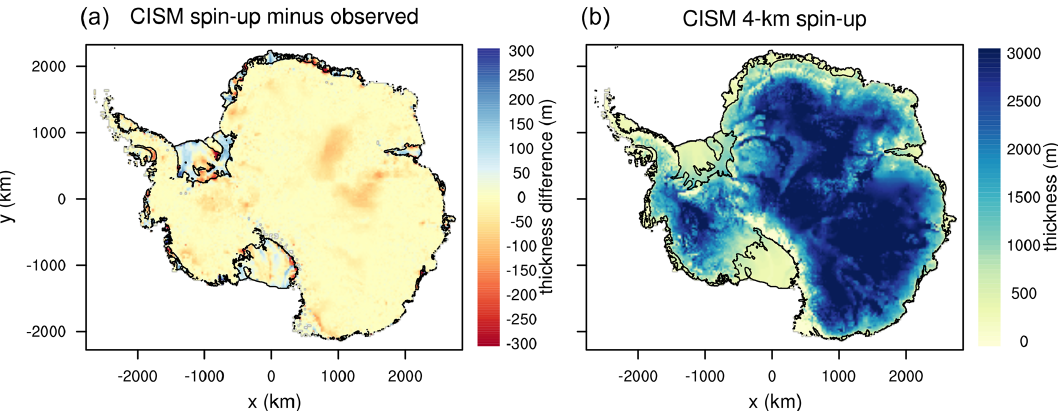
Figure 2. Difference between modeled and observed ice thickness (a) and modeled ice thickness (b) for the initial spin-up state used to initialize our 25 ensemble spin-ups (using p = 0 and γ 0 = 2062539), with root mean square error 51.8m. Observations are from the BedMachine Antarctica data set (Morlighem et al.,